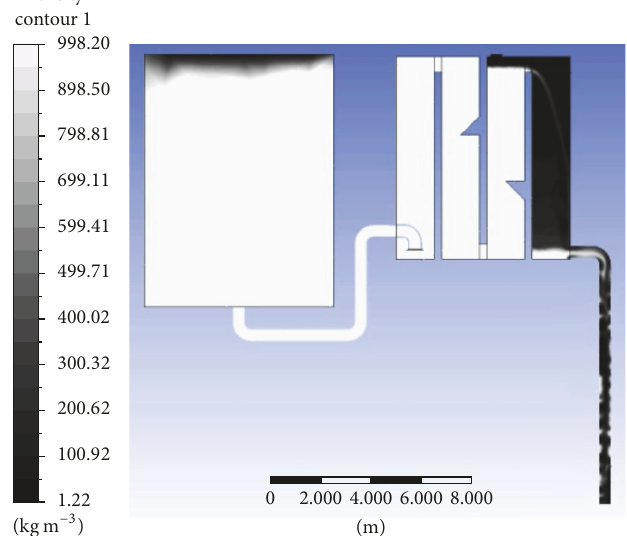
Figure 13: Simulation result of siphon breaking